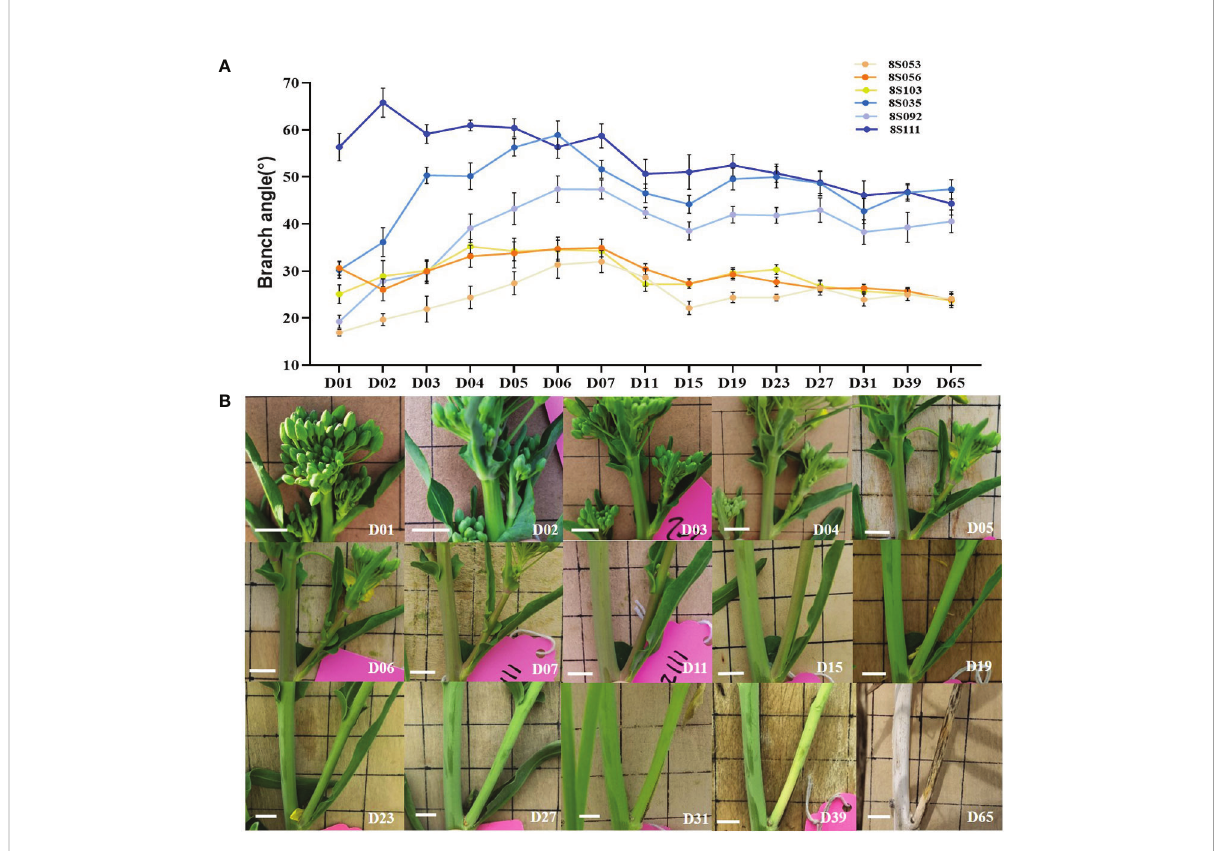
FIGURE 1 Dynamic observation of branch angle formation. (A) The branch angle of three compact (8S053, 8S056, 8S103, orange lines) and loose accessions (8S035, 8S092, 8S111, blue lines) were observed from branch emergence to maturity (D01- D65). (B) The branch angle dynamic variation of the compact accession (8S056) visually. D01 is the abbreviation of Day01, which means the fi rst day of branch